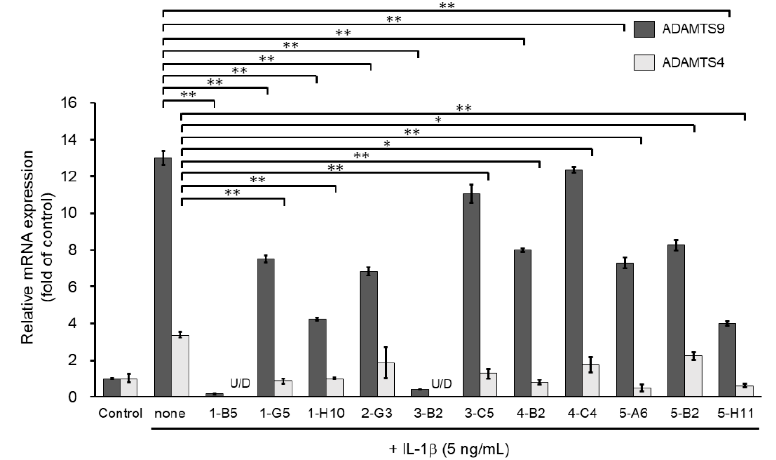
Figure 3. Inhibitory effects of candidate compounds on IL-1 β -induced ADAMTS4 and ADAMTS9 mRNA expression. Cells were treated with each compounds (10 µ g/mL) for 24 h, followed by the stimulation with IL-1 β (5 ng/mL) for 6 h. ADAMTS4 and ADAMTS9 mRNA levels were calculated relative to their mRNA levels in uninduced control cells. Values represent mean ± SE ( n = 6 per group). * p < 0.05 and ** p < 0.01, respectively.